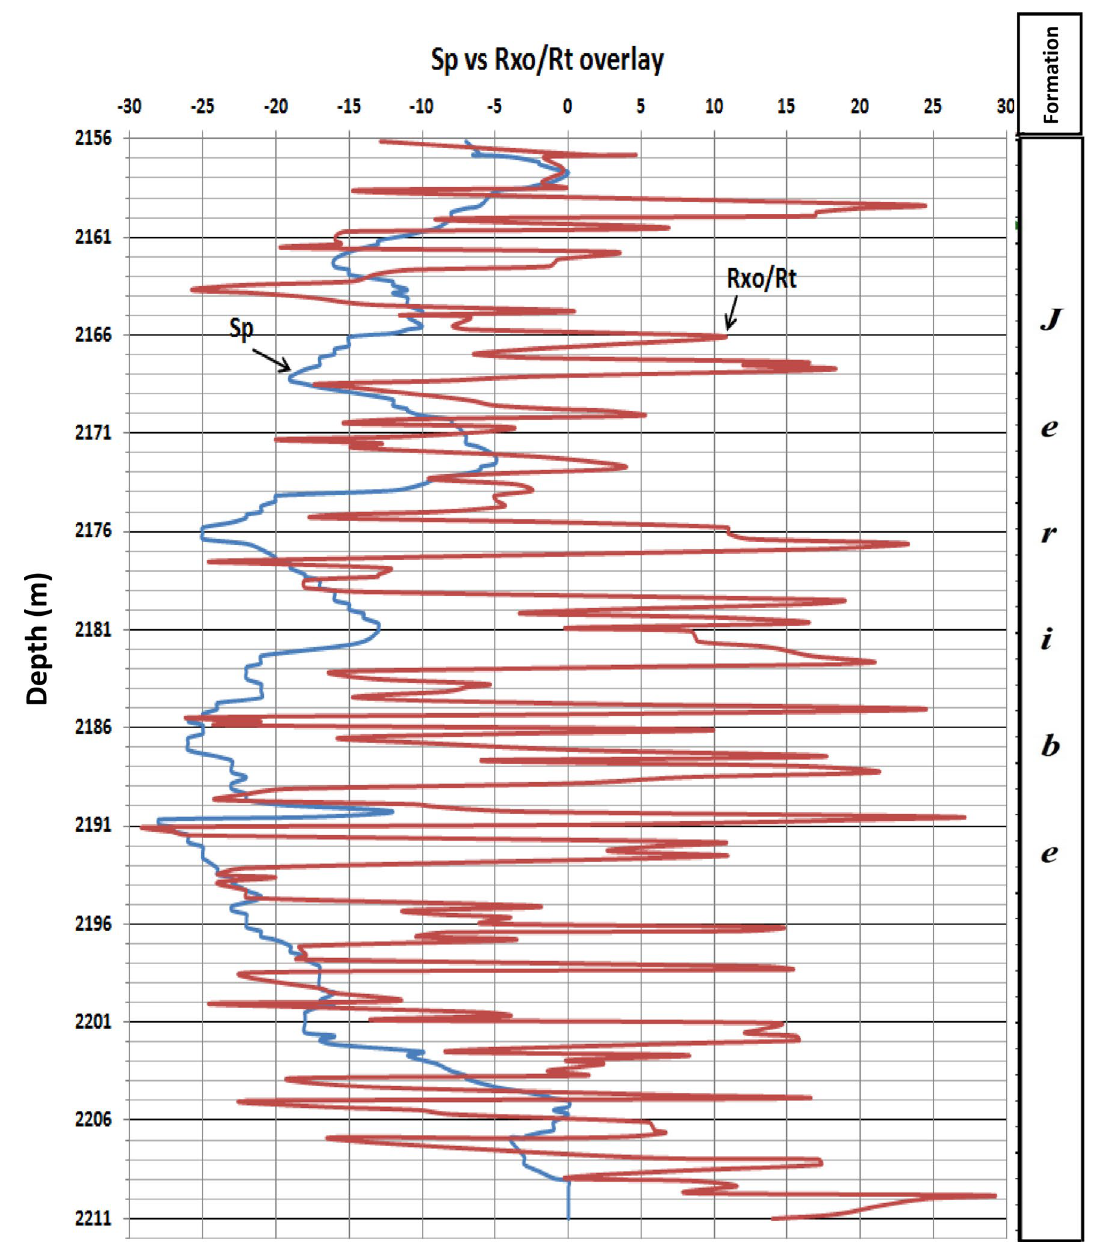
Fig. 5 SP versus R xo /R t overlay as a QLM for Jeribe Formation in the well